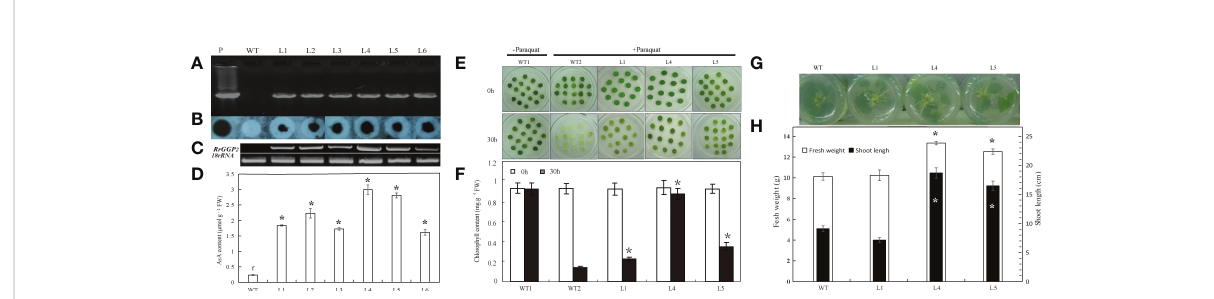
FIGURE 6 AsA content, oxidative resistance and growth status of tobacco overexpressing RrGGP2 . (A) PCR analysis for the presence of the RrGGP2 gene in Basta-resistant tobacco transgenic lines by cloning primers. (B) PCR-Southern dot blot analysis of the transgenic tobacco plants. Dot blot hybridization analysis following PCR products of the transgene RrGGP2 with CaMV 35S promoter-speci fi c primer and OCS PolyA-speci fi c primer, where the hybridization was performed with a CaMV 35S-speci fi c sequence as a probe. (C) RT-PCR analysis of total RNA from transgenic tobacco with RrGGP2 -speci fi c primers. (D) AsA content in the six transgenic lines and WT plants. Phenotypic difference (E) and chlorophyll content (F) of leaf discs after paraquat treatments for 30 hr under continuous light at 22 ± 2 °C. * Represents P < 0.05 compared with WT2. Rooting status after one week (G) and fresh weight and shoot lengths after ten weeks (H) of transgenic tobacco plants and control on rooting medium of 150 mM NaCl. *Represents P < 0.05 compared with WT, white represents fresh weight, and black represents shoot length. Lanes P = positive control pPFGC5941- RrGGP2 , WT = untransformed control plants, L1 – L6 = Basta-resistant T2 transgenic tobacco